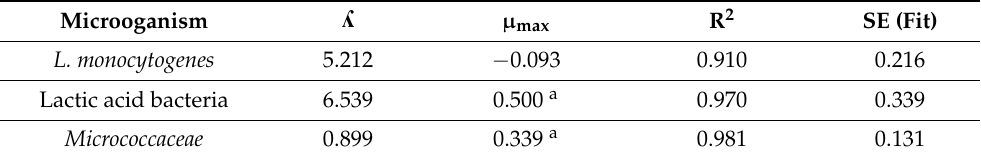
Table 2. Growth parameters of Listeria monocytogenes , lactic acid bacteria and Micrococcaceae .